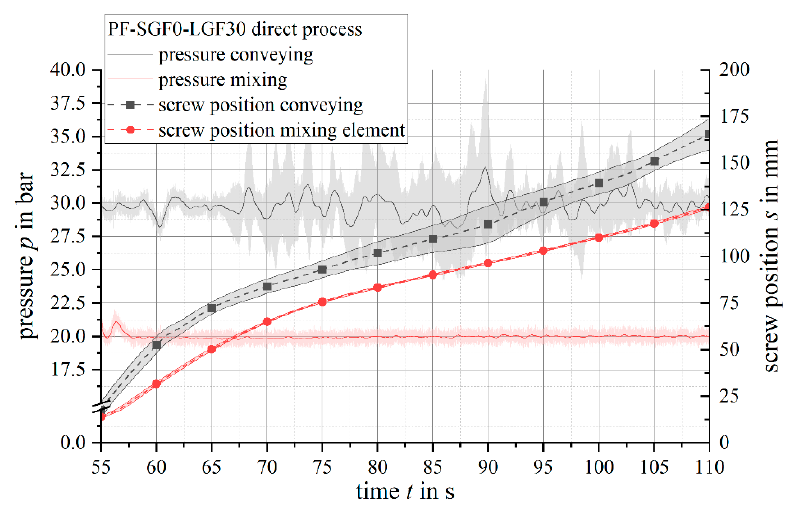
Figure 16. Pressure and screw position during plasticization of PF-SGF0-LGF30